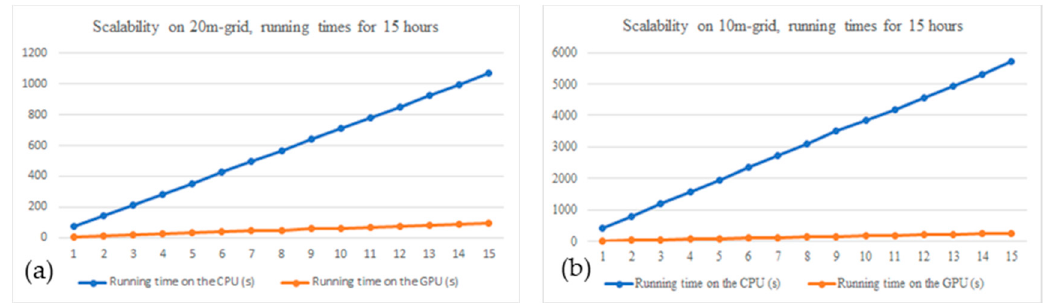
Figure 11. Scalability on 20 m-grid ( a ) and 10 m-grid ( b ); running time of 15 h.